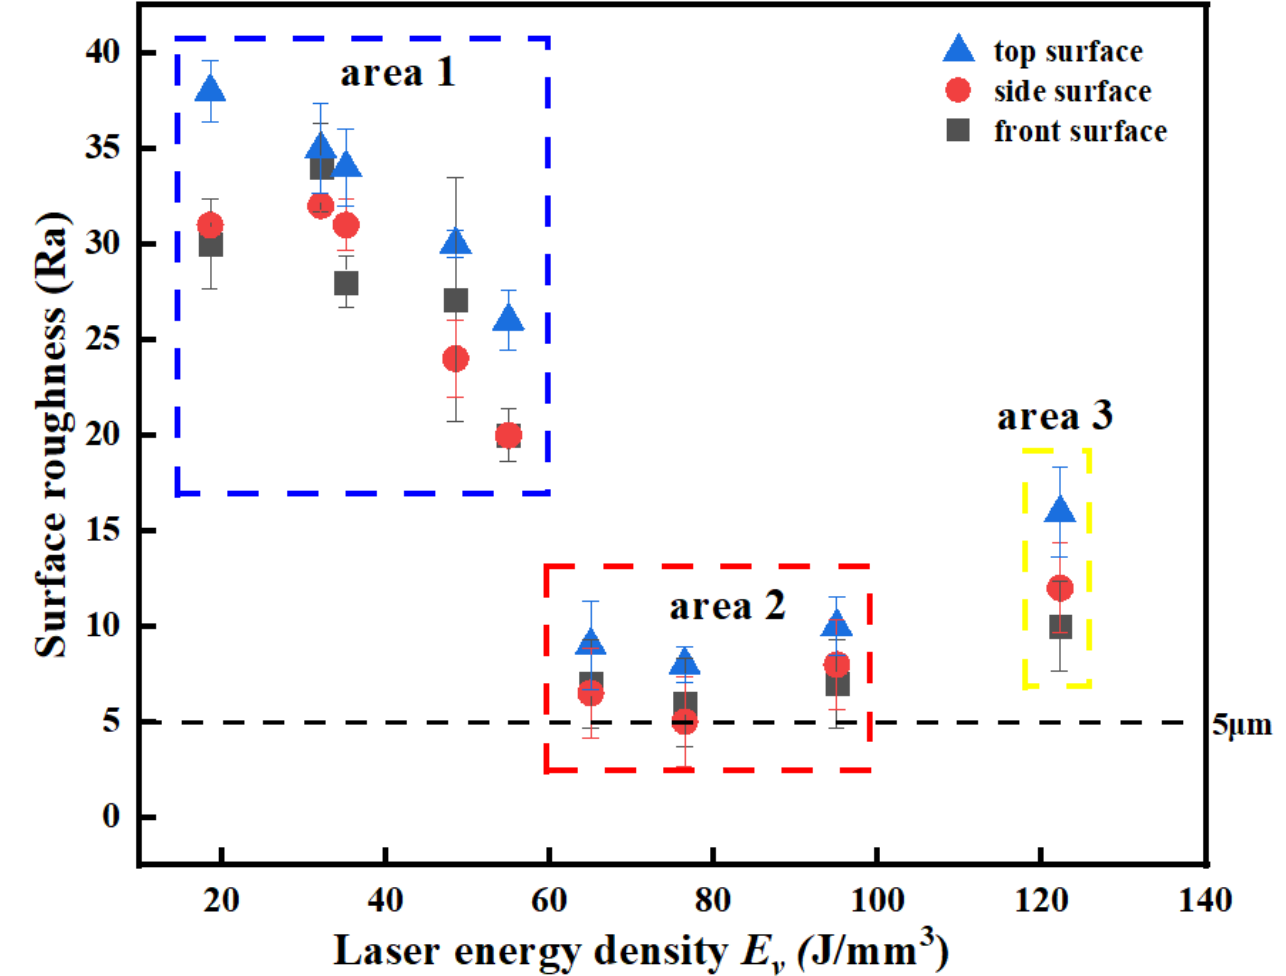
Figure 3. Relationship between surface roughness and laser energy density Ev.